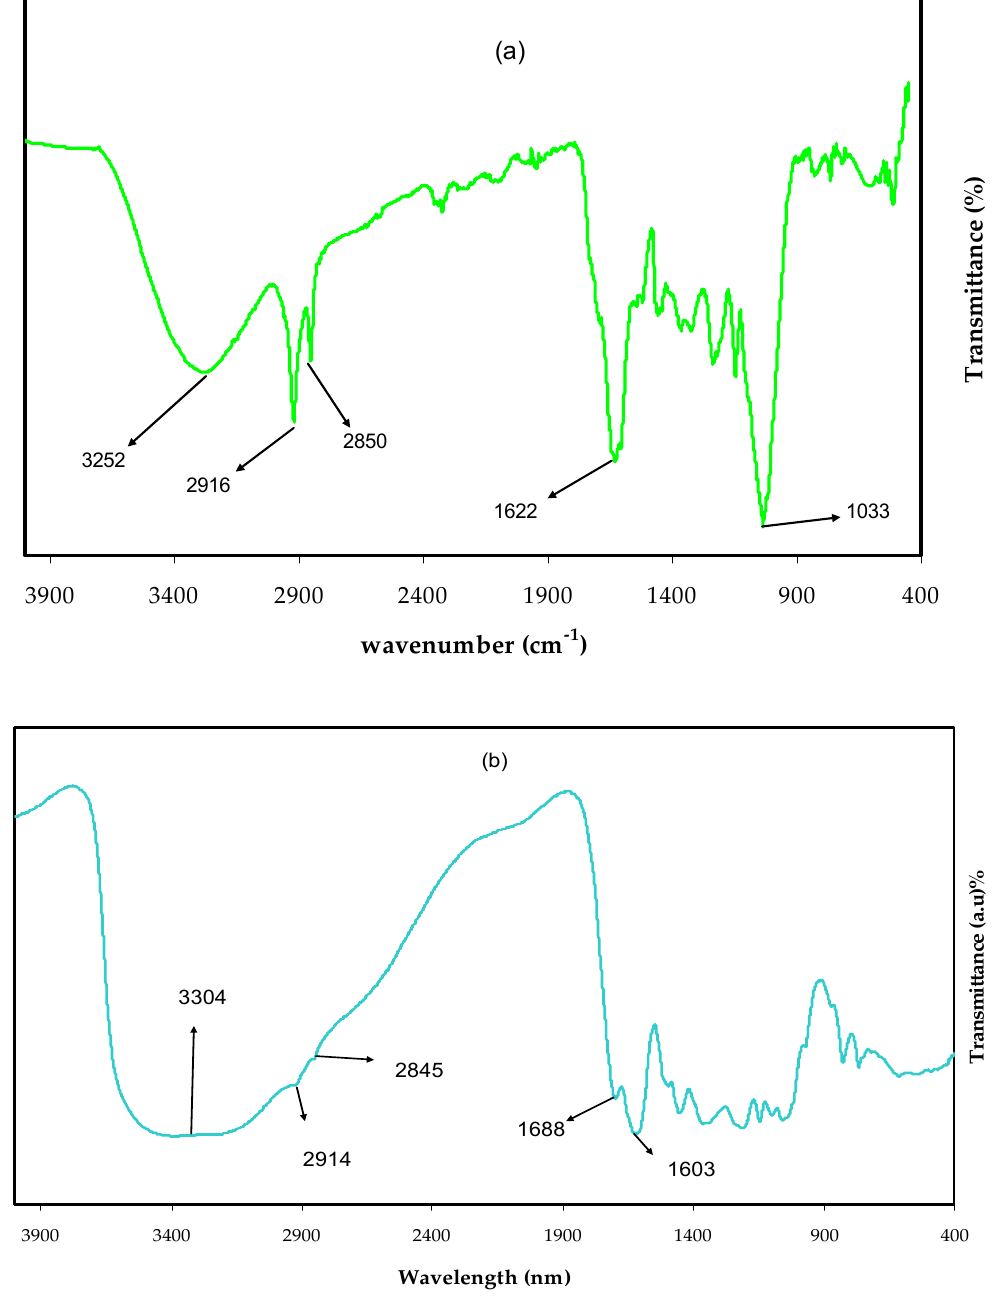
Figure 2. Spectra of the FTIR for the ( a ) extracted BTleaf and ( b ) colloidal Sn 2+ -PPHs metal complex.